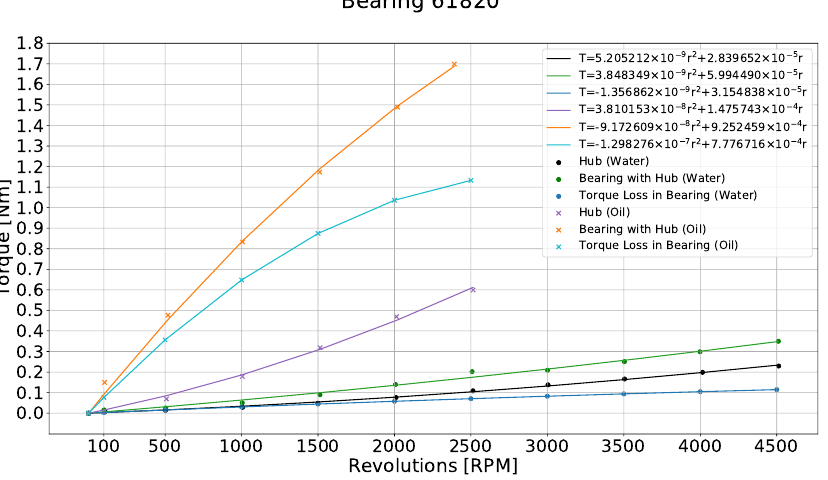
Figure 6. Bearing 61820—Torque losses in water and oil.